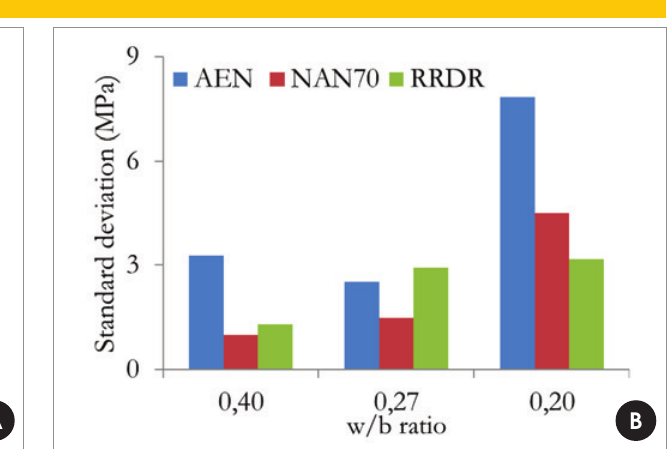
Figure 16 – Comparison between the lowest standard deviation values found for each technique of the three systems for conventional concrete (a) and high strength concrete (b)